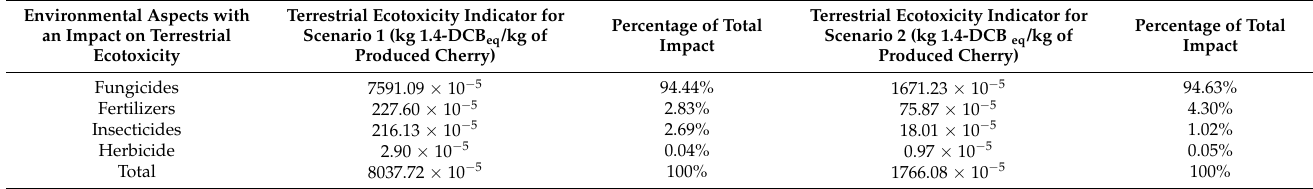
Table 6. Terrestrial ecotoxicity indicator for an FU of 1 kg of produced cherry for scenarios 1 and 2. Environmental Aspects with an Impact on Terrestrial